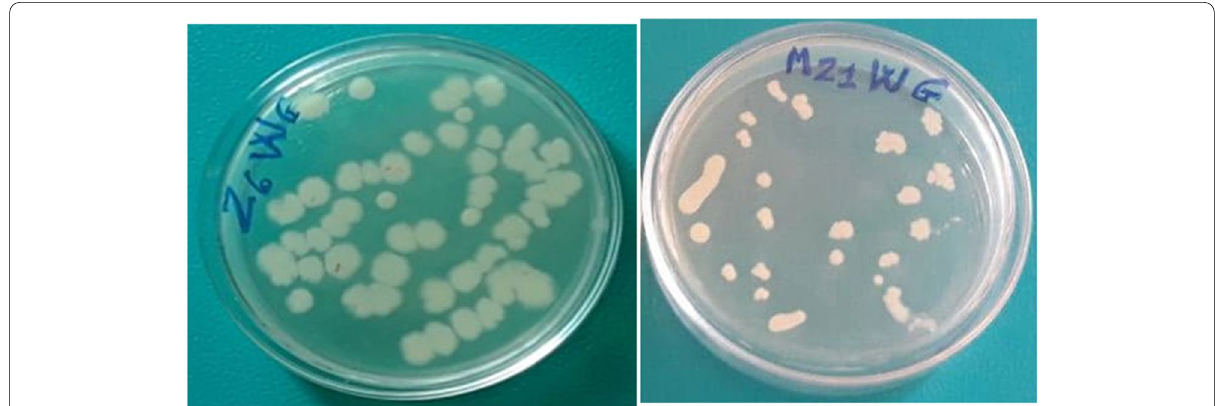
Fig. 2 Colony morphology of the isolated bacteria, M21WG, and Z6WG isolates